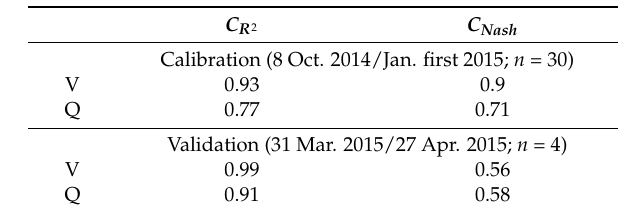
Table 3. Evaluation criteria for simulations of event runoff volumes (V) and instantaneous flow (Q) for the calibration ( n = 30 events) and validation ( n = 4 events) periods.